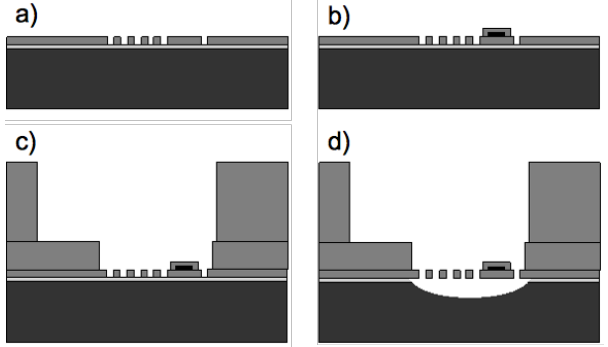
Figure 2. Fabrication sequence for the SU-8 devices: ( a ) Patterning of perforated cantilevers in SU-8. ( b ) Patterning of Al pad at the apex of the cantilever and encapsulation with SU-8. ( c ) Patterning of microfluidic channel in SU-8. ( d ) Isotropic etch of the Si support substrate.